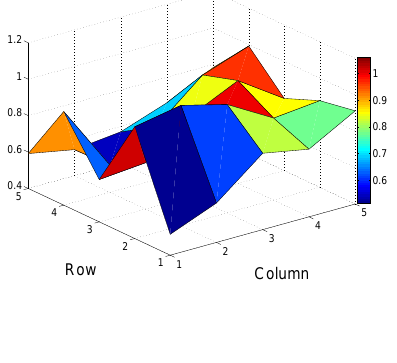
Table 2. The performance of three